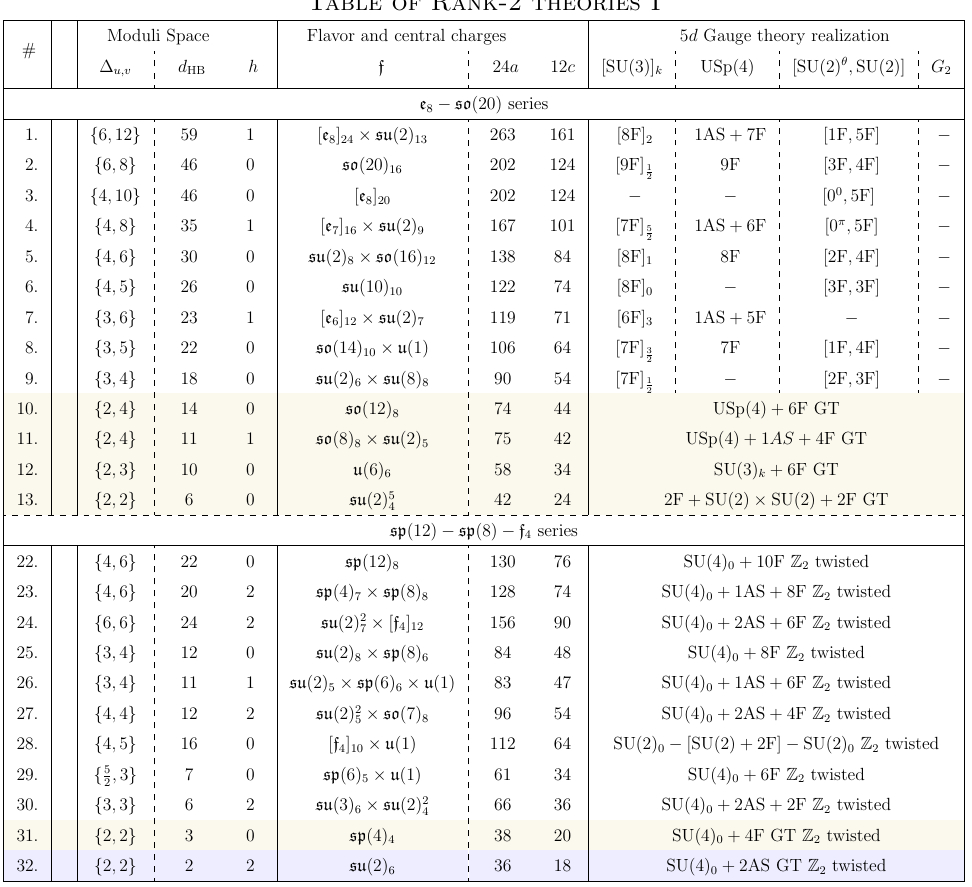
Table 1 . List of rank-2 4 d theories with their corresponding CFT data and 5 d origin. The last column in the table gives the 5 d gauge theory description of the 5 d SCFT whose compactification gives the 4 d SCFT. Here we shall usually give only one gauge theory description although others may exist. For most Lagrangian 4 d SCFTs, the 5 d parent is given by the compactification of a 5 d gauge theory, rather than a 5 d SCFT. This is denoted in the table by the label ‘GT’. When the compactification involves twisting, the discrete symmetry group being twisted is specified. In these cases this group is Z and it is manifested in the gauge theory as the combination of quiver 2 reflection and charge conjugation. Notice that we use the convention sp (2 n ) where n is rank. Also, compared to similar tables in [4], we won’t report the SCFTs which can be obtained by mass- deforming the Lagrangian theories. Finally we shade in yellow N = 2 Lagrangian theories and in blue N = 4